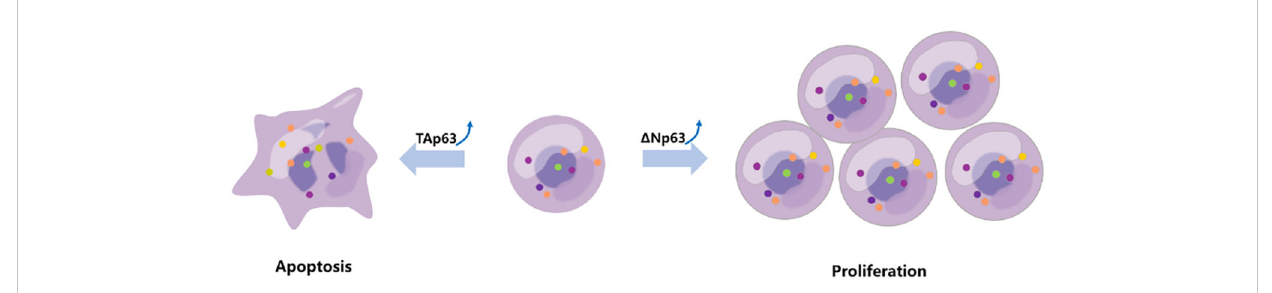
FIGURE 3 TAp63 and D Np63 exert different roles in response to chemotherapy. The TAp63 isoform is frequently associated with tumor suppression involved in cell cycle arrest, apoptosis, and DNA repair. In contrast, the D Np63 isoform serves as an oncogene, repressing proapoptotic genes, increasing chemotherapeutic resistance, and inducing cell